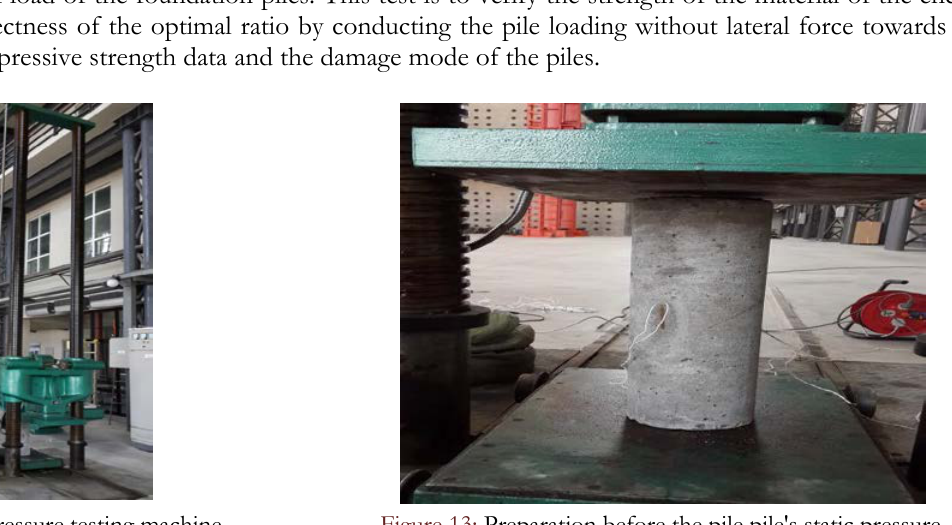
Figure 12: Hydraulic pressure testing machine. Figure 13: Preparation before the pile pile's static